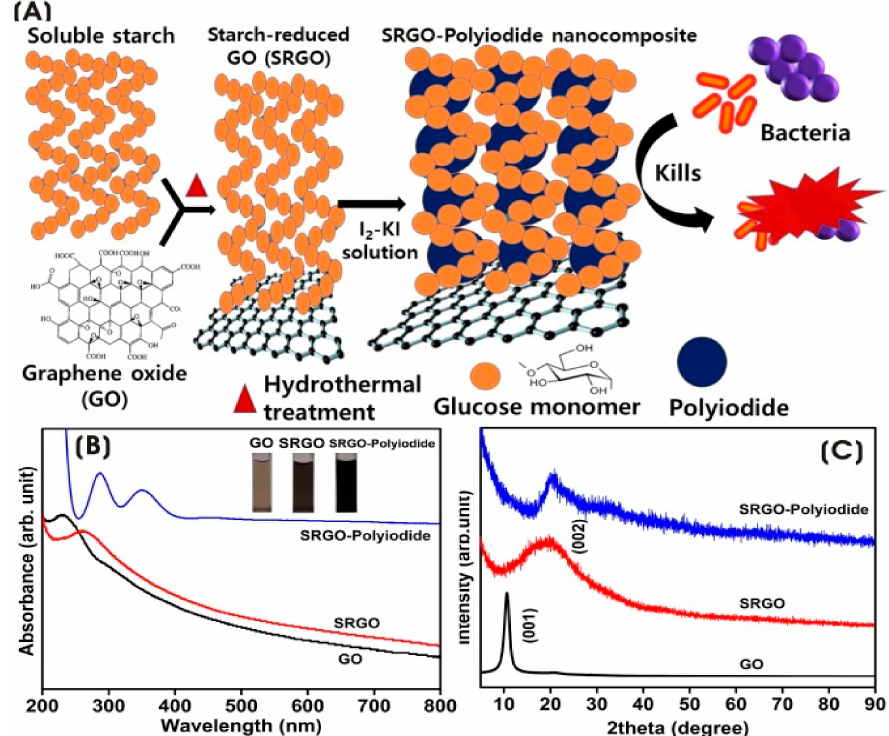
Figure 6. ( A ) Schematic representation of the synthesis of starch-reduced GO (SRGO)–polyiodide nanocomposite. ( B ) UV-vis spectra and ( C ) XRD pattern of GO, SRGO and the nanocomposite. Reprinted with permission from ref. [71]. Copyright 2021